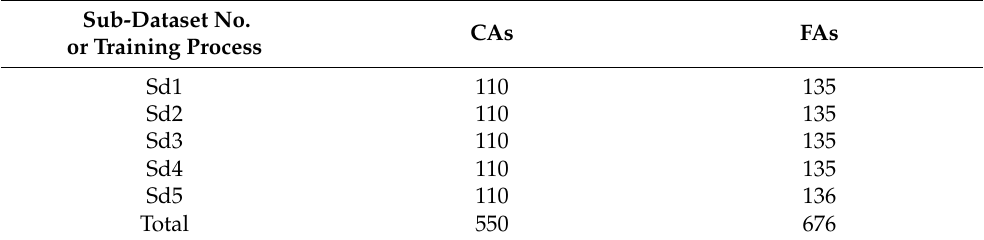
Table 1. Division of